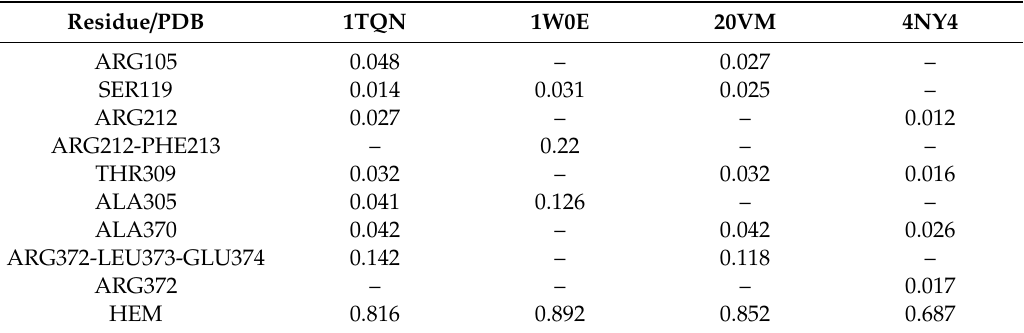
Table 6. Fractional number of transferred electrons ( ∆ N) calculated for the interactions between AFB1 and the CYP3A4 protein (using di ff erent PDB